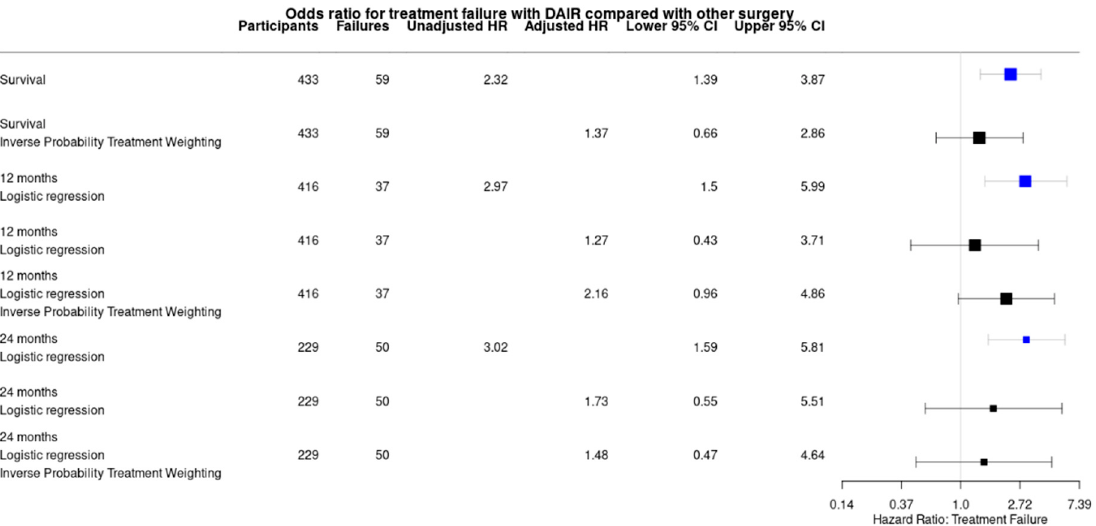
Figure 3. Hazard risk ratios comparing DAIR to other forms of surgery, depending on analysis performed. Point estimates were given with their 95% confidence limits.